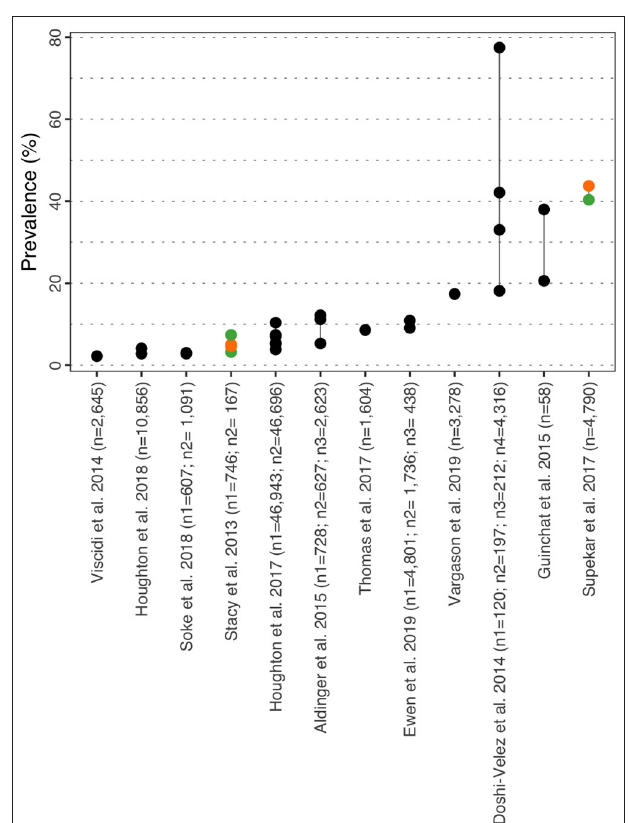
FIGURE 6 | Epilepsy prevalence estimates. Each point reports a prevalence estimate for the related comorbidity. Studies with more than one data point indicate the estimate of the prevalence among different subgroup of the population. See Supplementary Table 4 for the description of the population used in each study. Sample sizes are shown in brackets above each study label. Orange mark: Female population only; Green mark: Male population only; Black mark: No sex